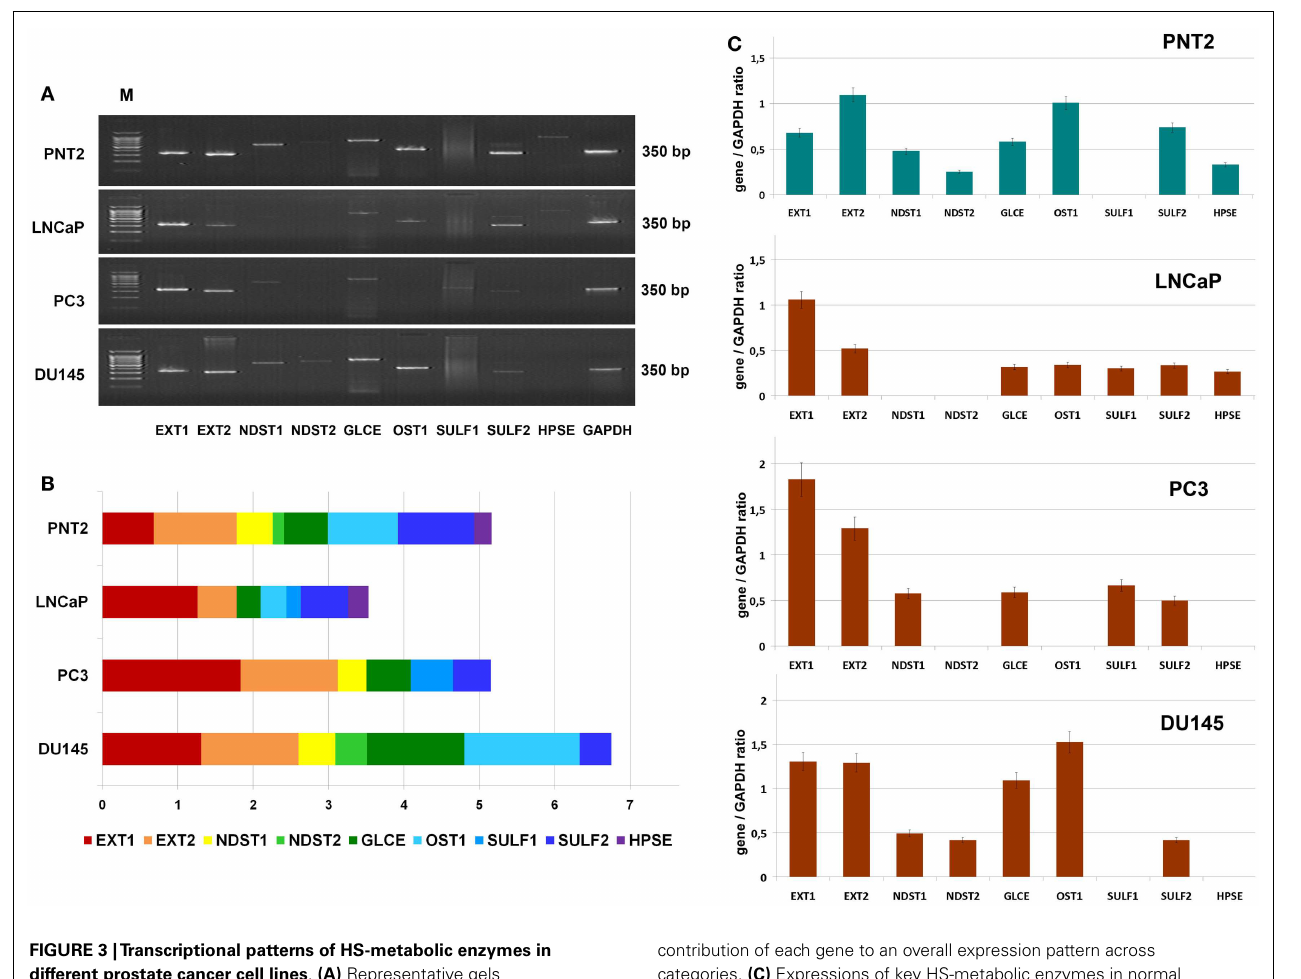
FIGURE 3 |Transcriptional patterns of HS-metabolic enzymes in different prostate cancer cell lines . (A) Representative gels showing the expression levels of HS metabolism-involved genes amplified by RT-PCR. (B) Transcription patterns of HS-biosynthetic machinery in the cell lines. Stacked column compares the